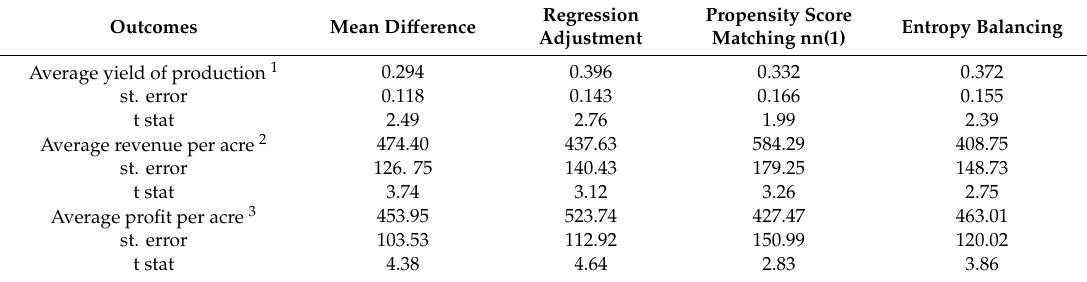
Table 5. Treatment e ff ects for the outcomes of revenue, profitability, and